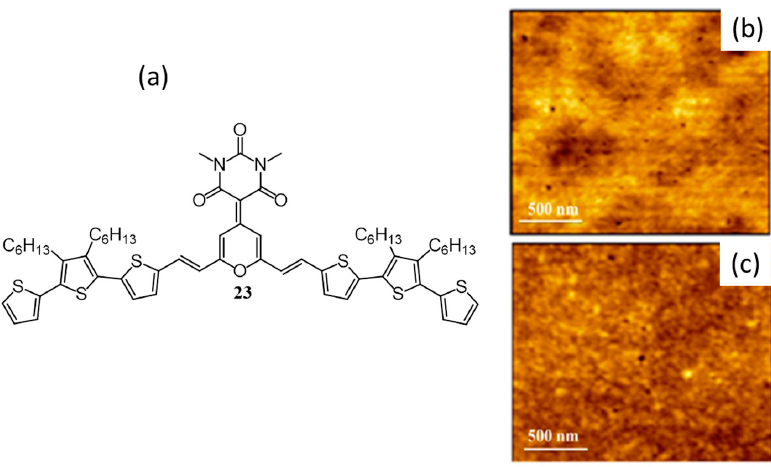
Figure 10. ( a ) Chemical structure of 23 synthesized by Patil et al. [57]. AFM images of 23 ( b )